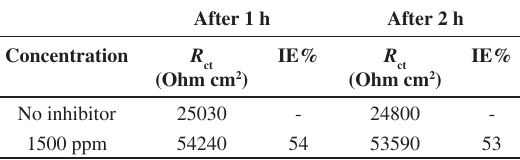
Table 5. Change of R and IE% values for the corrosion of Al- ct 2007 alloy in 3.5% NaCl in the presence of 1500 ppm mad honey after 1 and 2h.